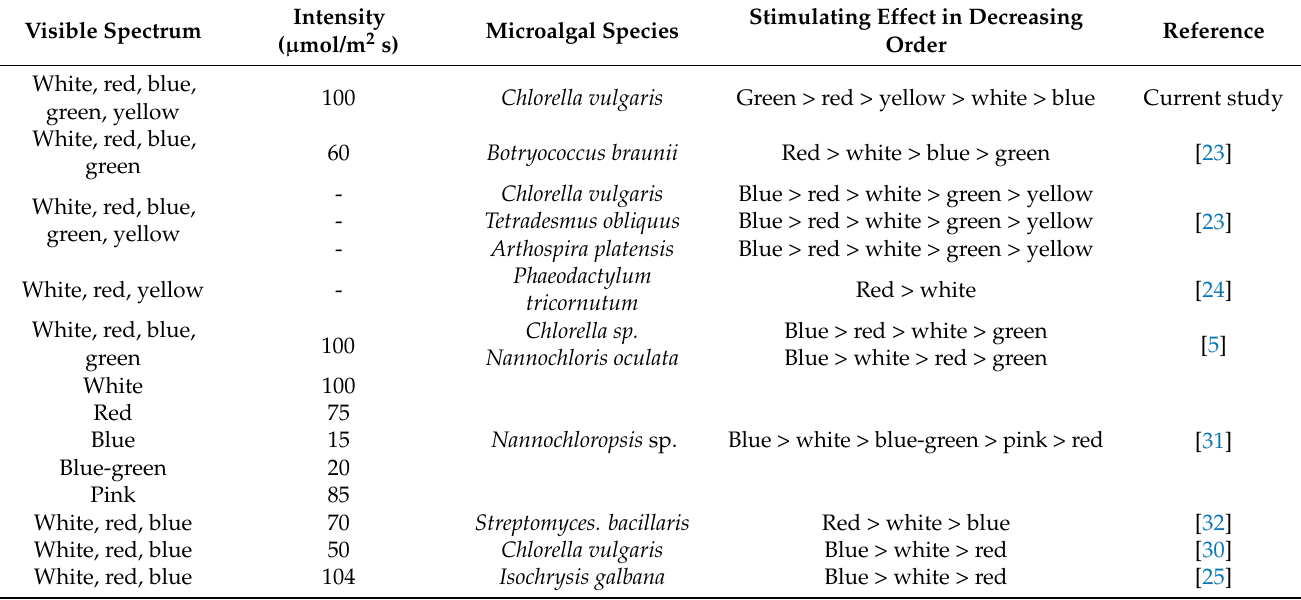
Table 2. Microalgal lipid accumulation responses to various visible spectra of irradiation.